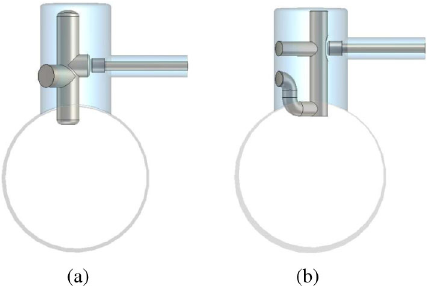
FIG. 3. (a) HOM coupler with one-leg-design (HOM1Leg). (b) HOM coupler with two-leg-design